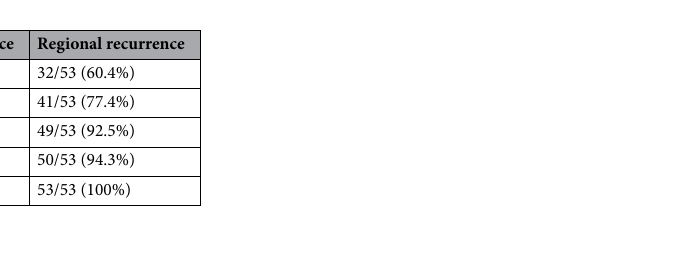
Table 2. Time of